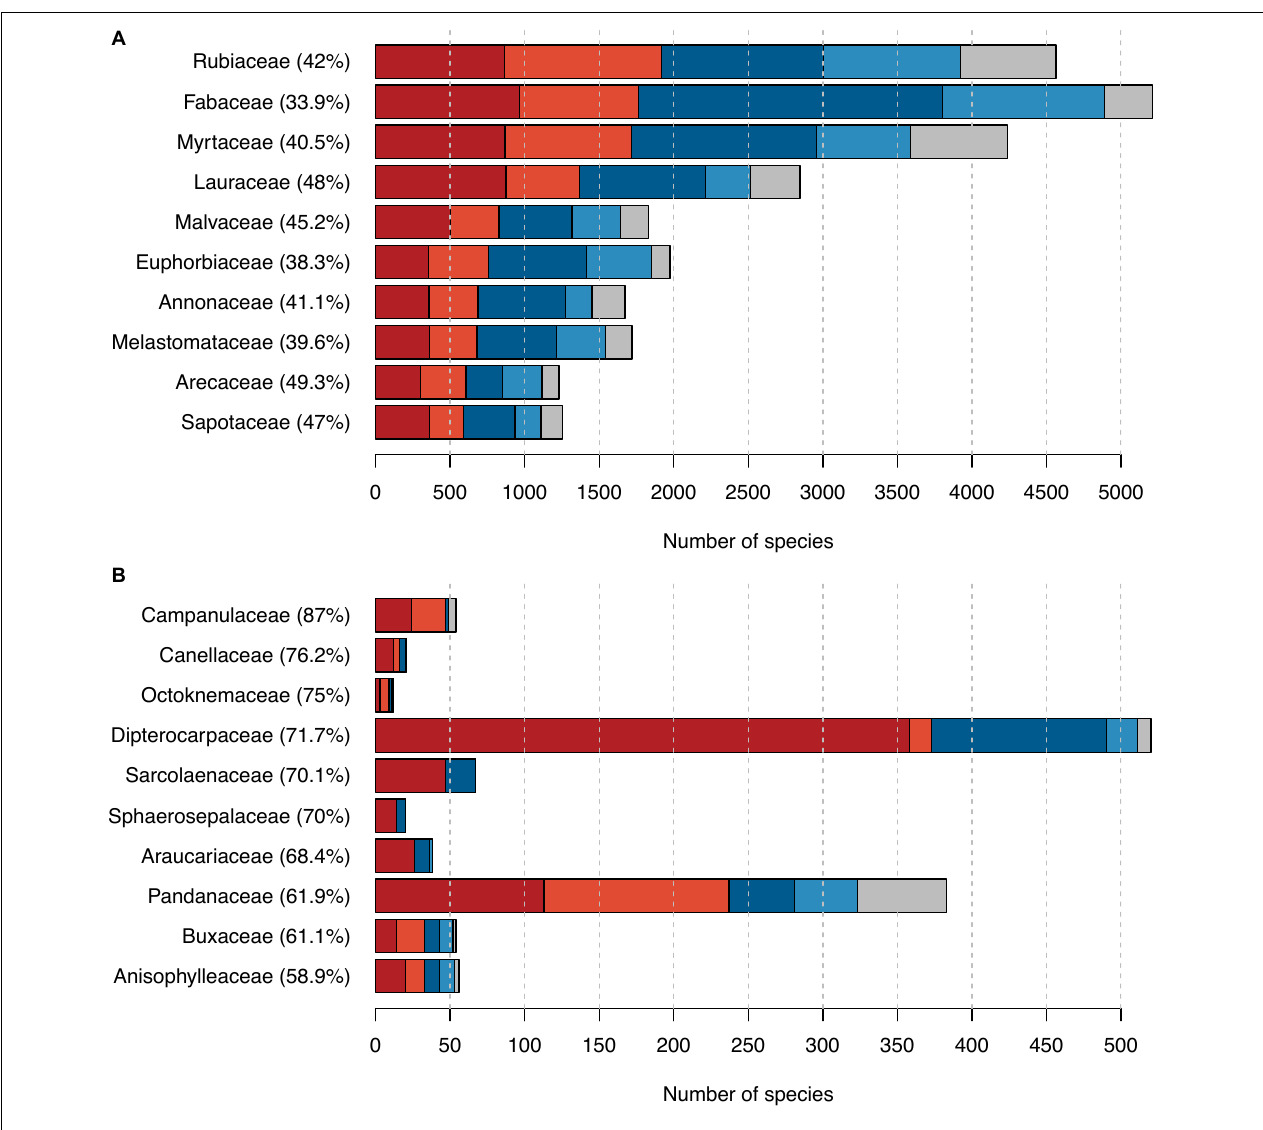
FIGURE 2 | The proportion of possibly threatened species among trees grouped by families. (A) The 10 families with the highest number of possibly threatened tree species and (B) the 10 families with the highest proportion of possibly threatened tree species (and comprising more than 10 tree species in total). Red indicates counts of possibly threatened species, and blue indicates counts of possibly not threatened species, with darker shades used for IUCN RL assessments and lighter shades for our automated assessments. In gray, we showed the number of species not assessed. Percentages next to family names indicate the percentage of possibly threatened tree species in this